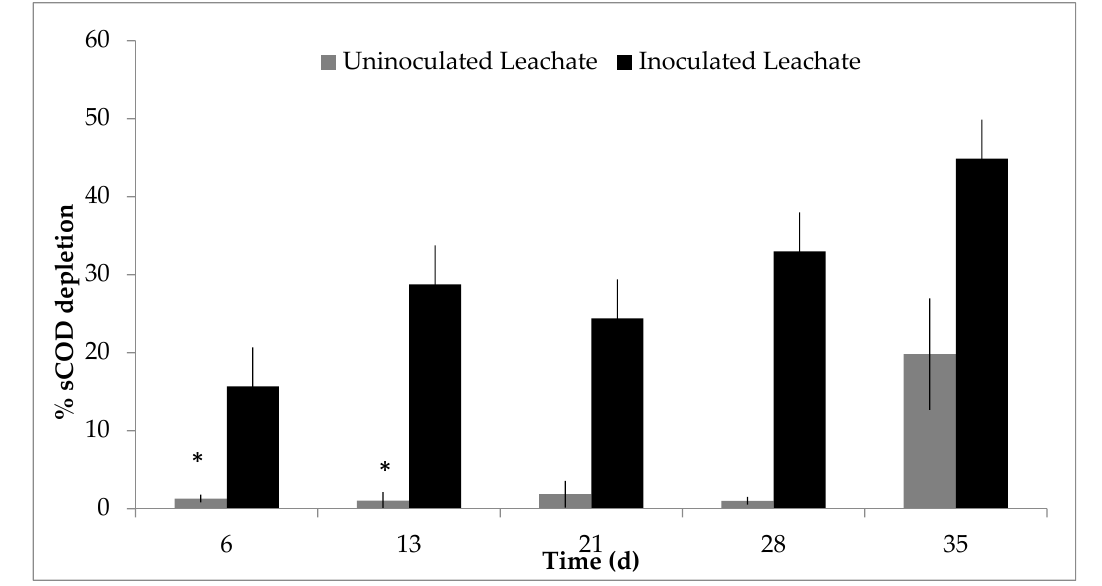
Figure 2. Percentage of sCOD depletion in Cuoio Depur old LFL using Lambertella sp. immobilized on PUFs, in presence of 0.1% (v/v) of Malt Extract Broth (MEB). Values represent mean values of the percentage of sCOD depletion from three biological replicates with reference to the initial concentration. Bars represent the standard deviation (SD) among the three replicates of analysis. All the values are significantly different from the corresponding value at the previous time of analysis at the 1% level (p < 0.01), with the exception of the bars with asterisk (*).